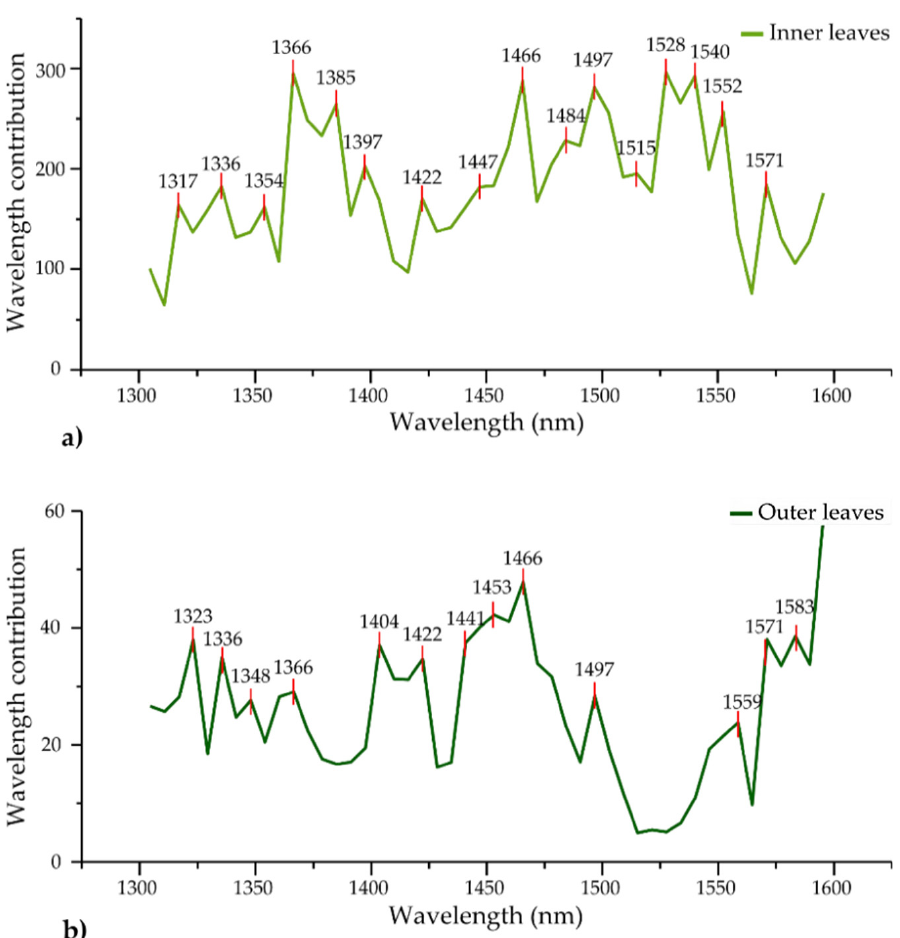
Figure 10. Wavelength contributions to PCA ‐ LDA classification model when “storage time” was the class variable ( a ) on the data of inner leaves (raw spectra, N = 450, NrPCs = 24), and ( b ) on the data of outer leaves (deTr ‐ treated spectra, N = 450, NrPCs = 30). The common absorbance bands were found at 1336, 1366, 1422, 1466, 1497 and 1571 nm. Except for the last one, the listed wavelengths are within the ranges of C1, C2, C6, C9 and C11 WAMACs. The absorbance band at 1336 nm was a very strongly influential band